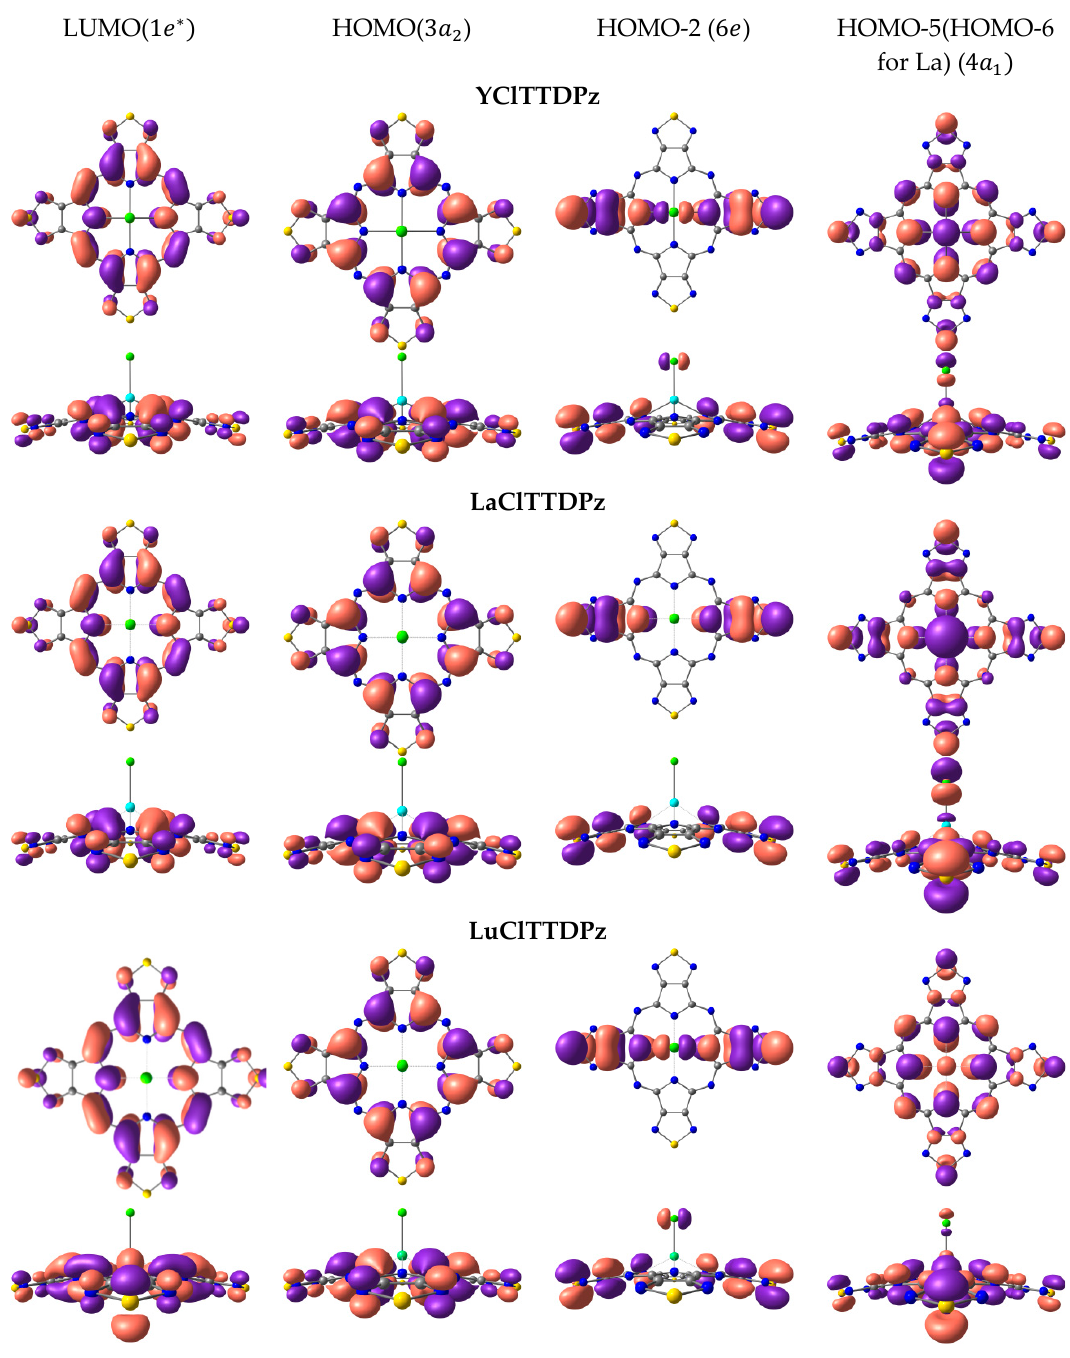
Figure 5. Influence of the metal (Y, La, Lu) on the molecular orbitals of MClTTDPz complexes.